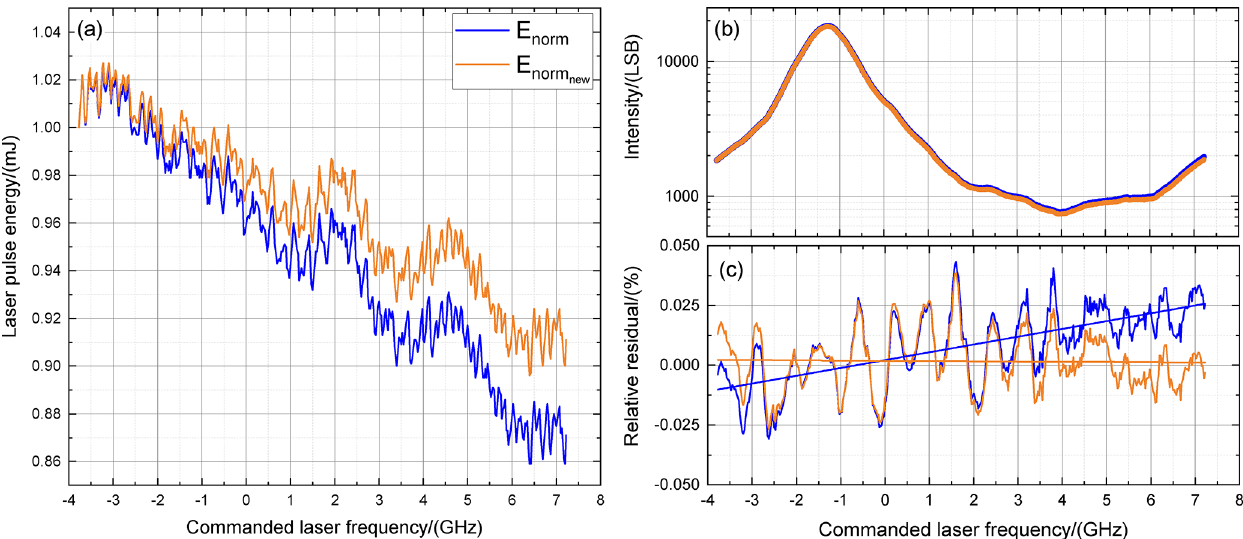
(f ) (orange) versus commanded laser new (f ) (orange dots) for the laser energy drift correction. To illustrate new